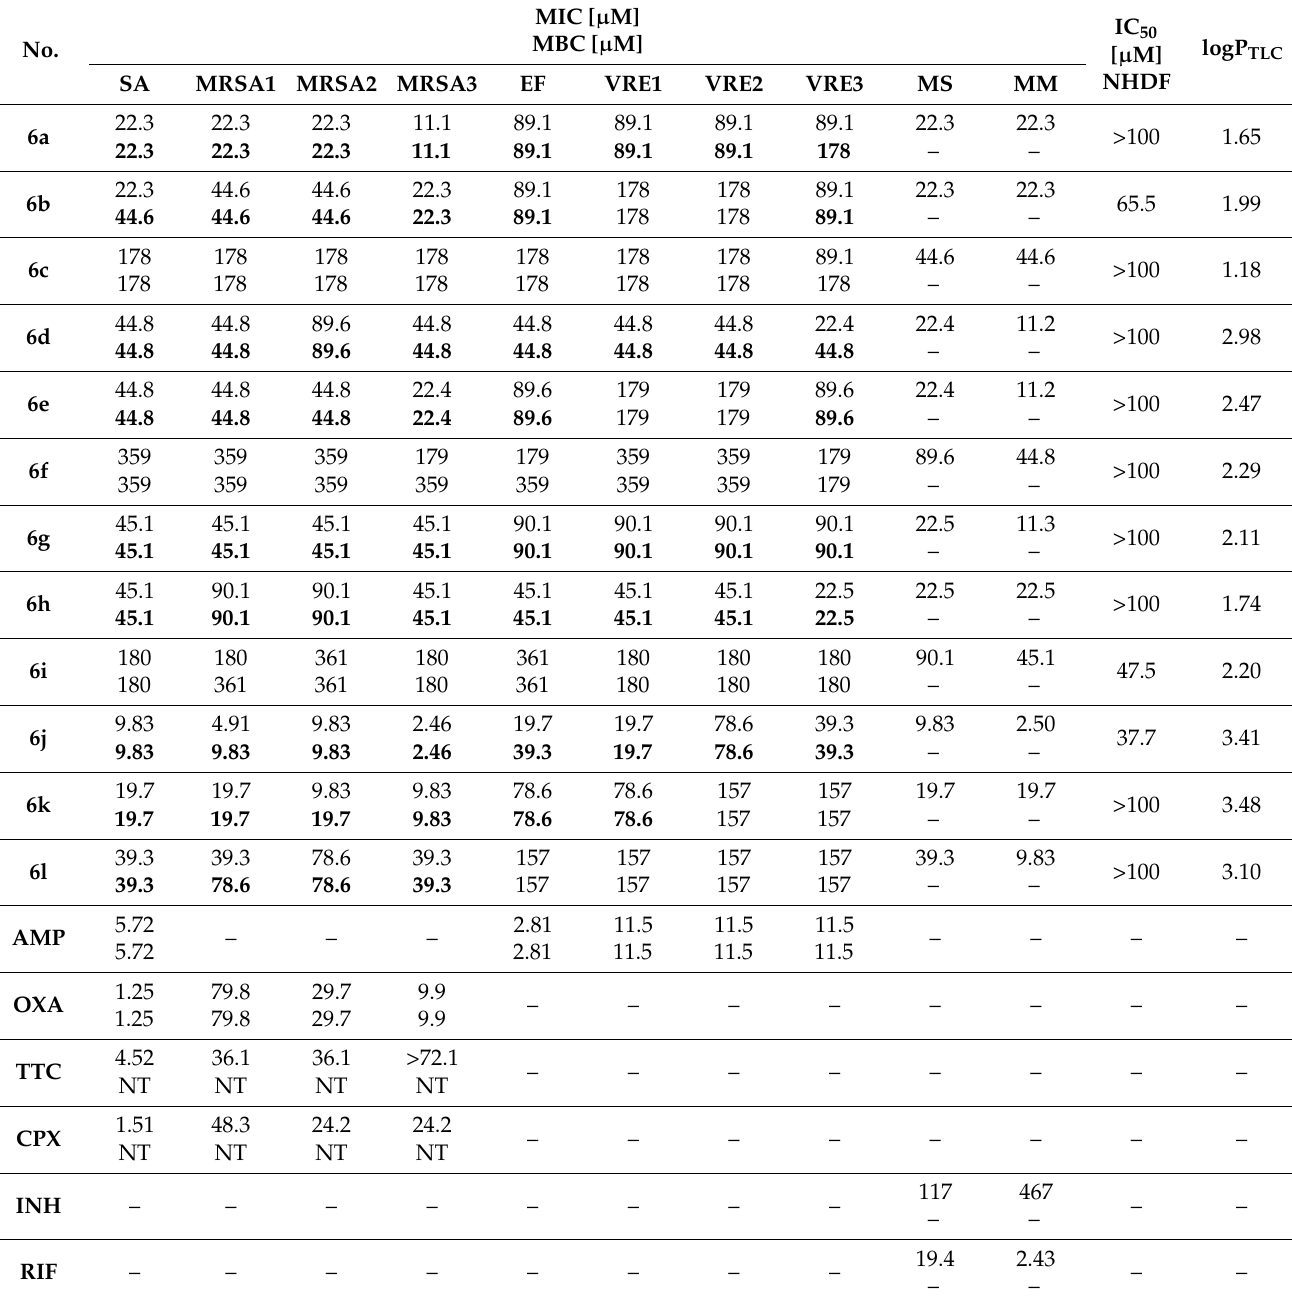
Table 1. In vitro antistaphylococcal, antienterococcal activities (MIC/MBC [ µ M]) compared to ampi- cillin (AMP), oxacillin (OXA), tetracycline (TTC) and ciprofloxacin (CPX). Antimycobacterial activities (MIC [ µ M]) compared to isoniazid (INH) and rifampicin (RIF), and in vitro cell viability on